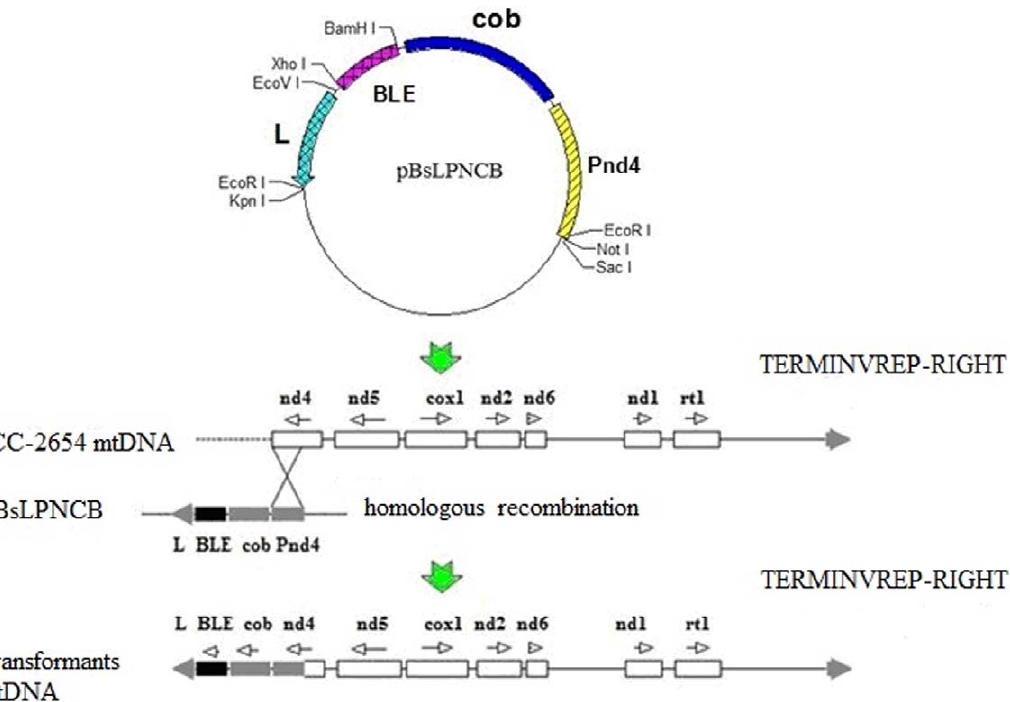
Figure 1. Schematic diagram of homologous recombination events between pBsLPNCB and CC-2654 mtDNA. The dotted line represents the deletion part of mtDNA in CC-2654 relative to wild-type CC-124. The empty boxes are the mitochondrial genes and the empty arrows above the genes indicate their transcription directions. The crossed solid lines denote the homologous recombination region between the CC-2654 mtDNA and expression vector pBsLPNCB.